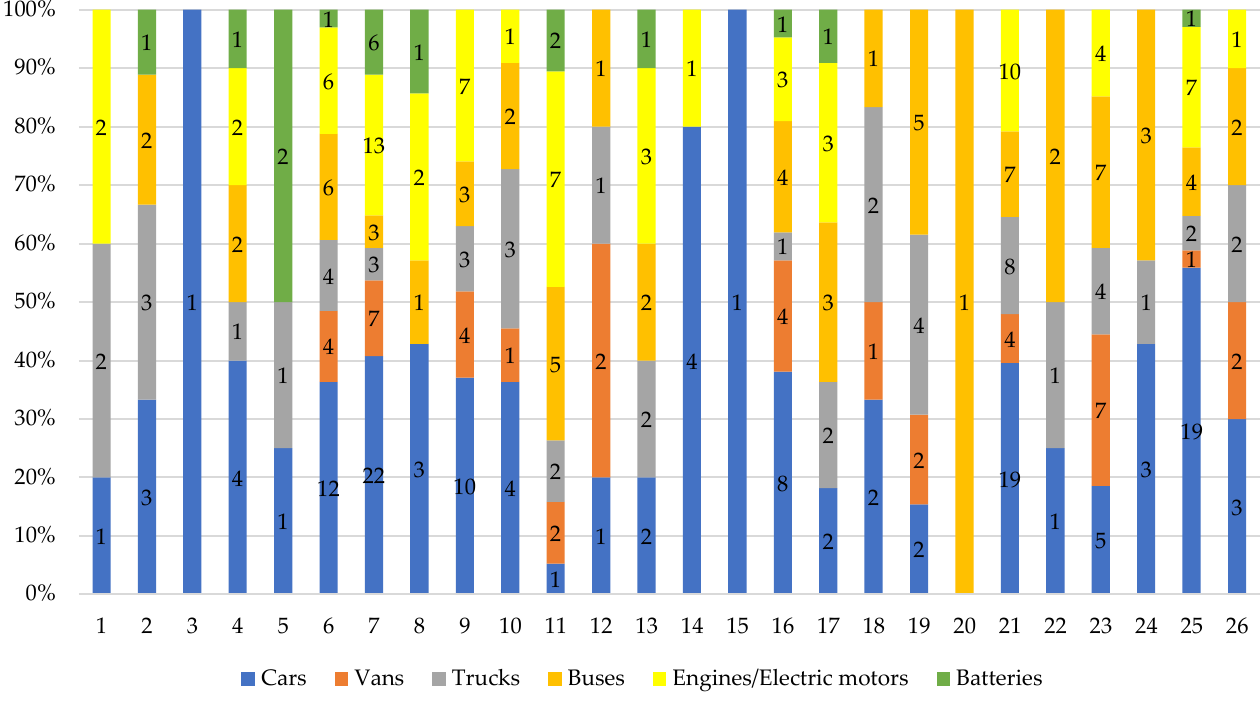
Figure 2. Automobile assembly and production plants in Europe: 1 — Austria; 2 — Belgium; 3 — Croatia; 4 — Czech Republic; 5 — Finland; 6 — France; 7 — Germany; 8 — Hungary; 9 — Italy; 10 — Netherlands; 11 — Poland; 12 — Portugal; 13 — Romania; 14 — Slovakia; 15 — Slovenia; 16 — Spain; 17 — Sweden; 18 — Belarus; 19 — Kazakhstan; 20 — North Macedonia; 21 — Russia; 22 — Serbia; 23 — Turkey; 24 — Ukraine; 25 — United Kingdom; 26 — Uzbekistan.